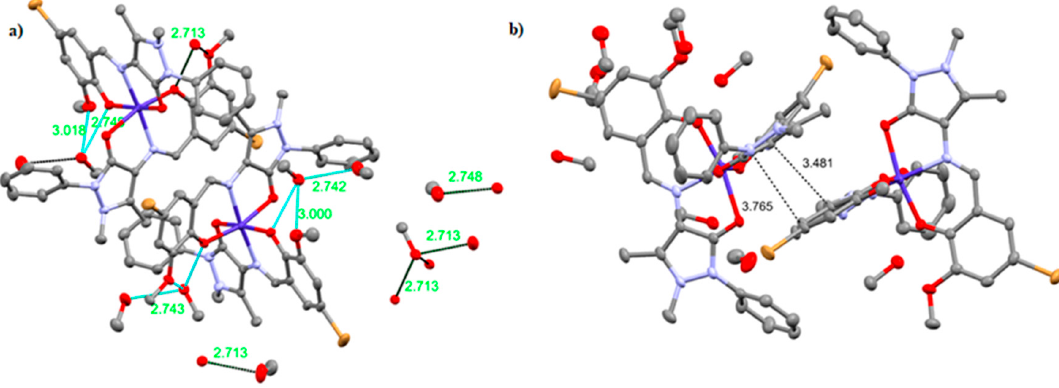
Figure 2. ( a ) Hydrogen bonding ( b ) π - π stacking interaction in 1